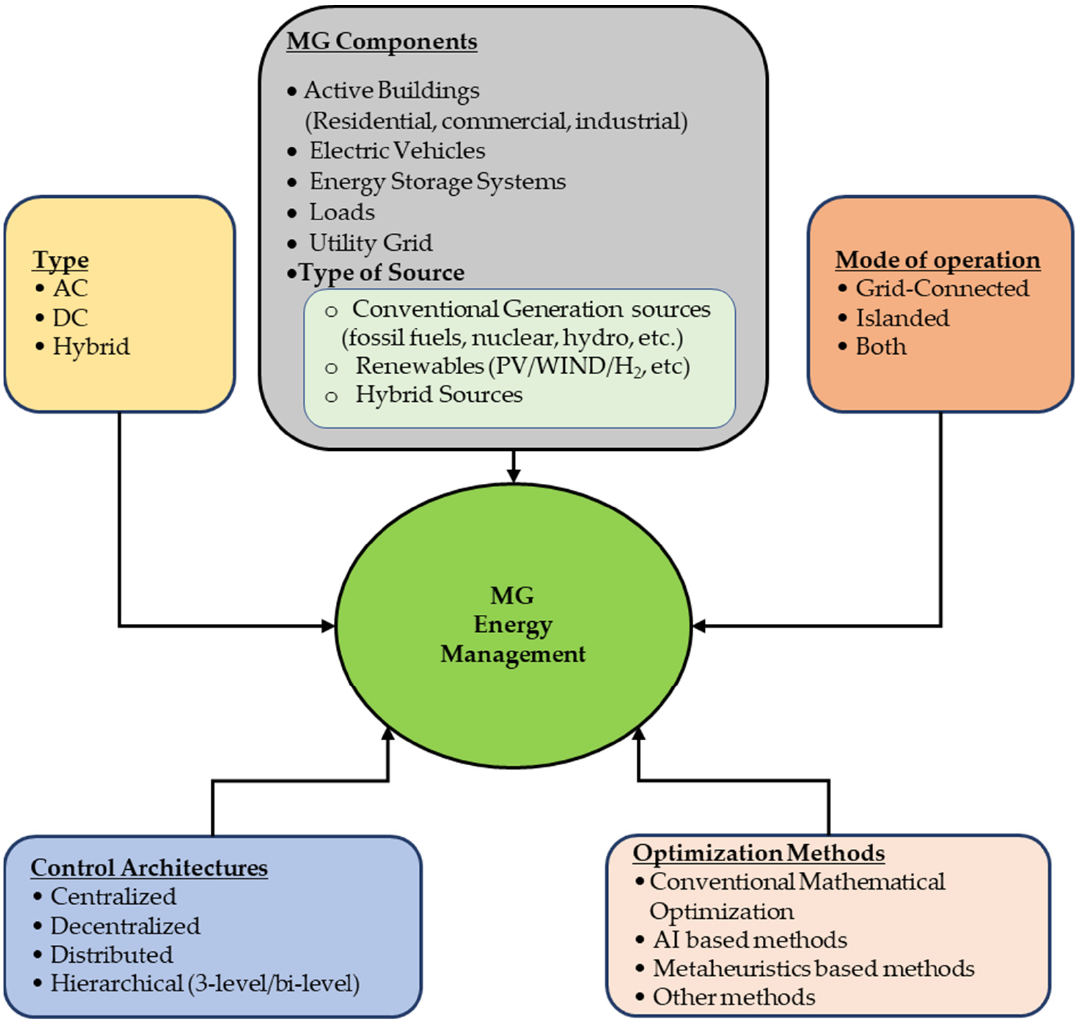
Figure 1. MG components, type, mode of operation, control, and optimization methods.